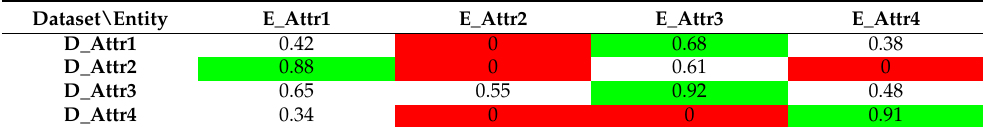
Table 5. Example 1: Attributes-pairs matching result.